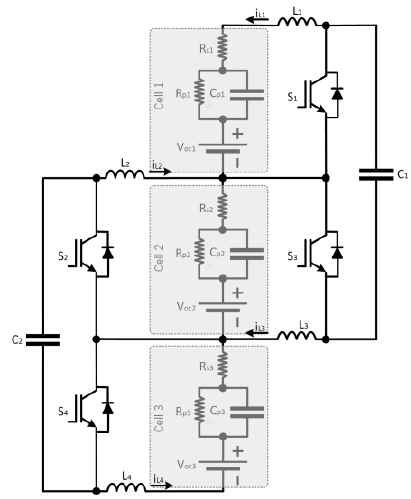
( b ) Figure 13. Operating modes of the SwI converter: ( a ) discharging of cell 1; ( b ) charging of cell 2. 2.6. Cuk The Cuk type power converters can be applied in the balancing of cells in a battery. The main advantage of balance using Cuk converters is the control of the input current and the current delivered to each cell. In this way, none of the cells presents a pulsating current. However, they are expensive because they have more components, and the de- sign can be complex [23]. Cuk is a non-isolated dc–dc converter, whose main characteristic is to present an in- verse voltage at the output. The conventional circuit of the Cuk converter is represented in Error! Reference source not found. . The Cuk converter presents a bidirectional energy transfer capacity with high efficiency. This requires 2(n − 1) controlled semiconductors